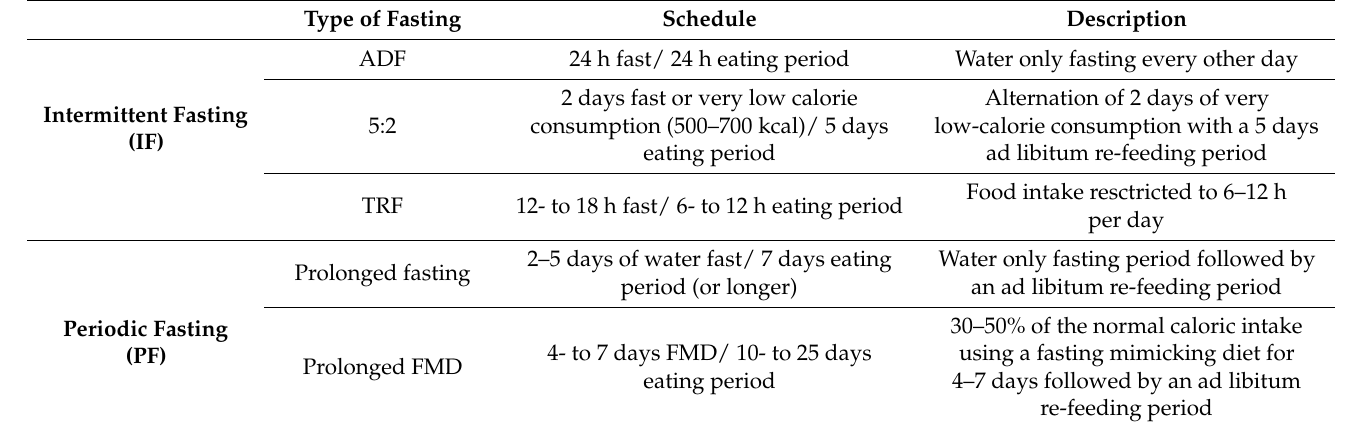
Table 2. Dietary approaches to promote health